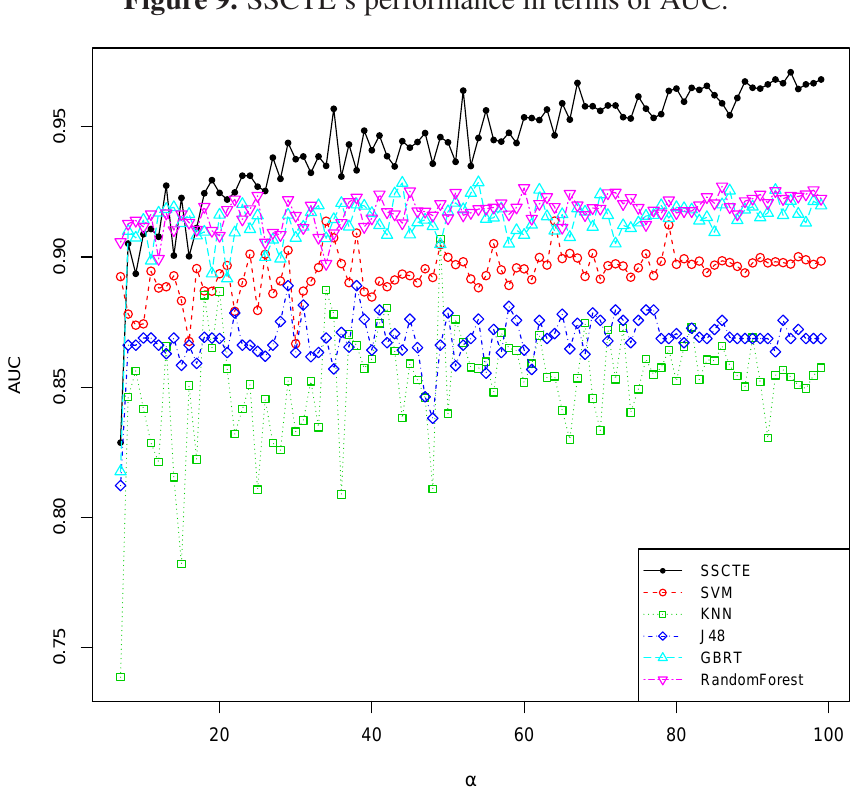
Figure 9. SSCTE’s performance in terms of